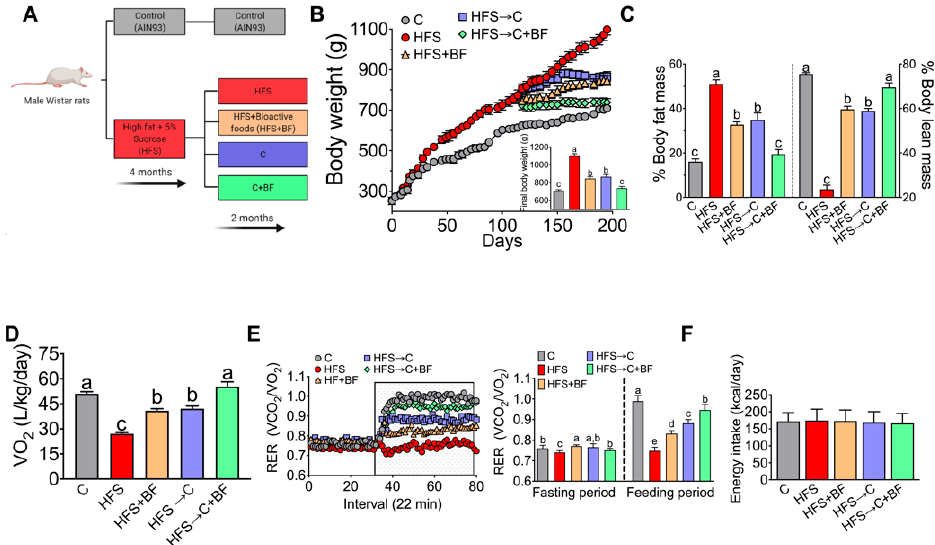
Figure 1. Bioactive foods decreased body weight and increased energy expenditure. ( A ) Experimental design, ( B ) Body weight gain, ( C ) Body composition, ( D ) Energy expenditure, ( E ) Respiratory exchange ratio (RER) and ( F ) Energy intake in rats fed control (C) or high fat diet + 5% sucrose (HFS) with or without bioactive foods (BF). Data are expressed as the mean ± SD. Mean values with different letters show statistical differences between each other (a > b > c > d). Data were analyzed by one-way ANOVA followed by Tukey post-hoc test. Results were considered statistically significant at p < 0.05. Panel A was created with BioRender.com (accessed date 19 December 2021).